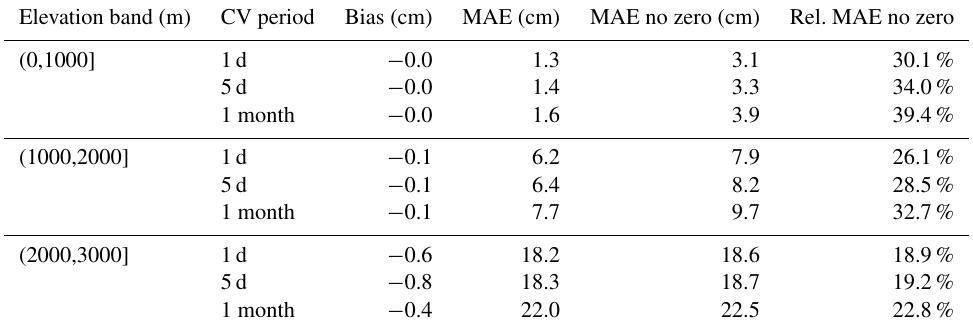
Table A1. Cross-validation (CV) metrics for the gap-filling approach: bias (the difference between gap-filled and observed values), the mean absolute error (MAE), mean absolute error only for non-zero observed values (MAE no zero), and MAE no zero divided by the average of all true non-zero values (Rel. MAE no